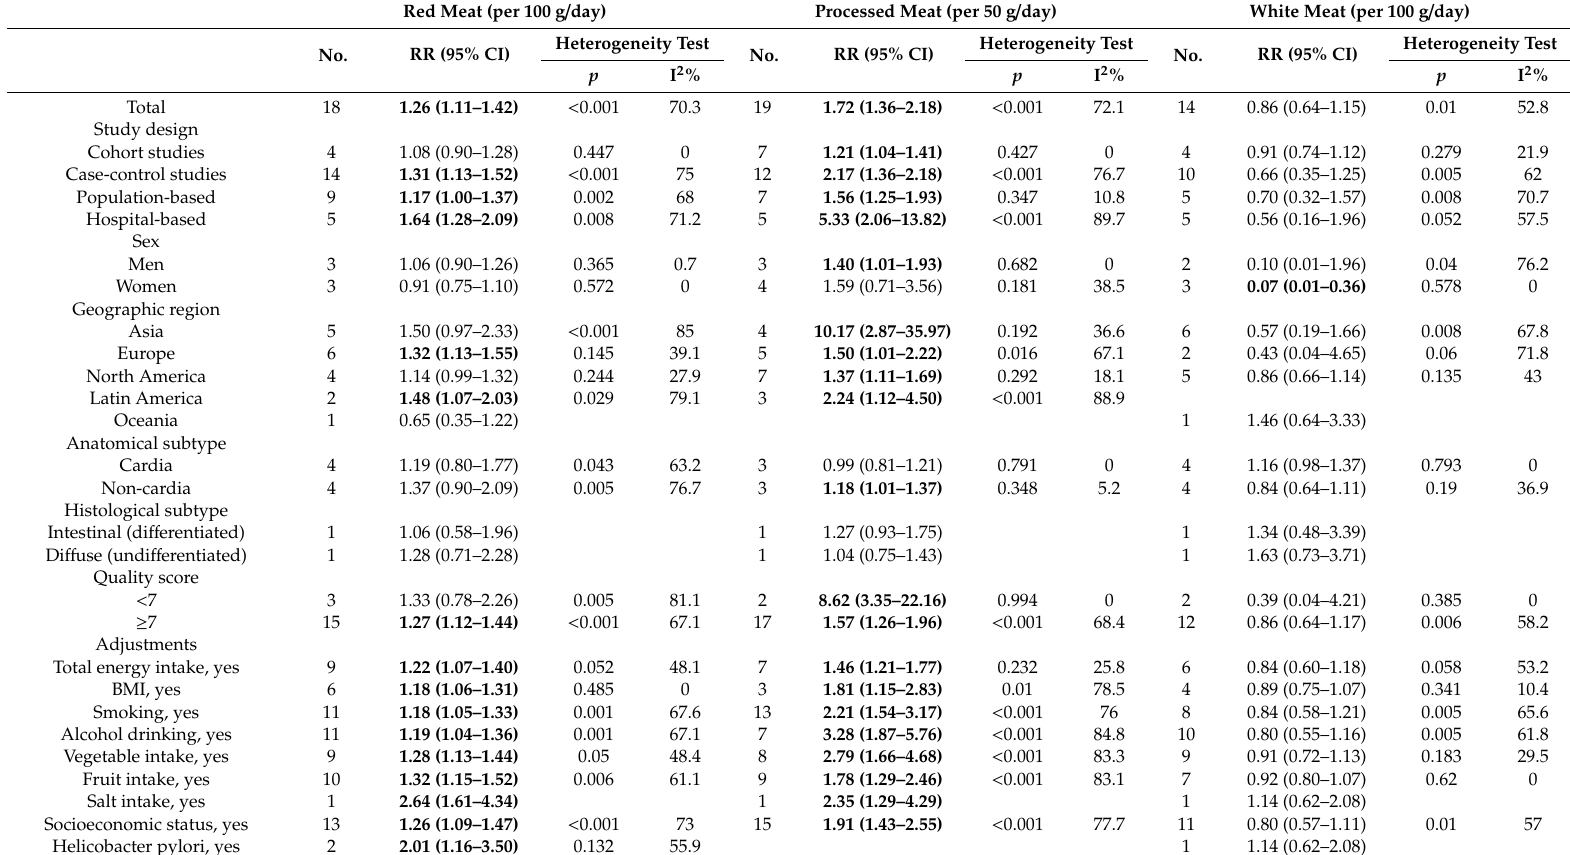
Table 3. Stratified dose–response analysis of red, processed, and white meat consumption and gastric cancer